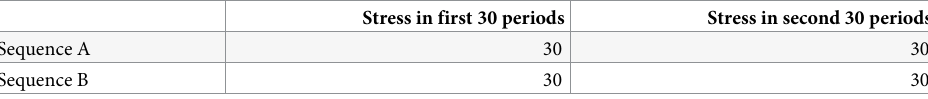
Table 2. Experimental design and number of